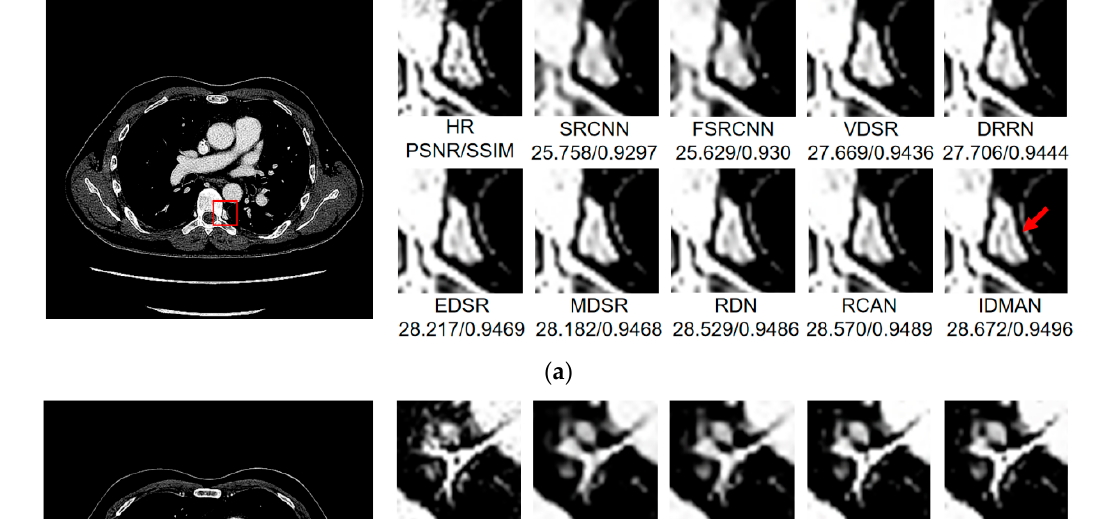
Figure 7. Convergence analysis with scaling factor × 2 : ( a ) The PSNR curve during training; ( b ) The L1 loss curve during training.